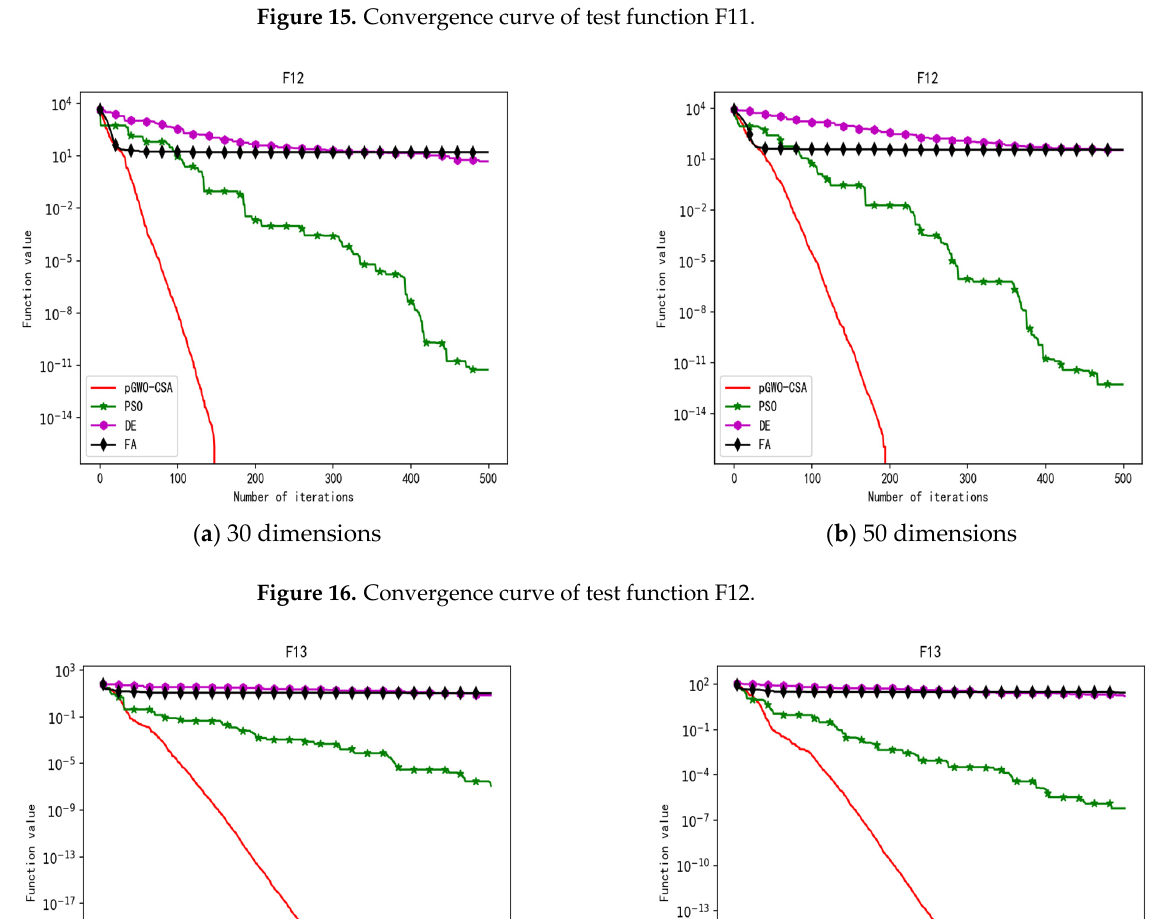
Figure 15. Convergence curve of test function F11.